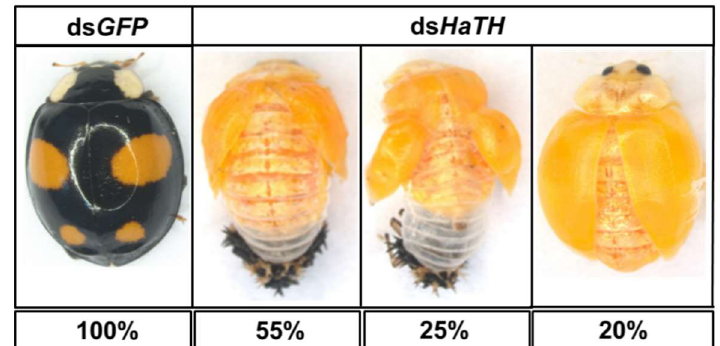
Figure 4. The phenotypes of an abnormal adult from the fourth instar larvae of H. axyridis injected with ds HaTH .